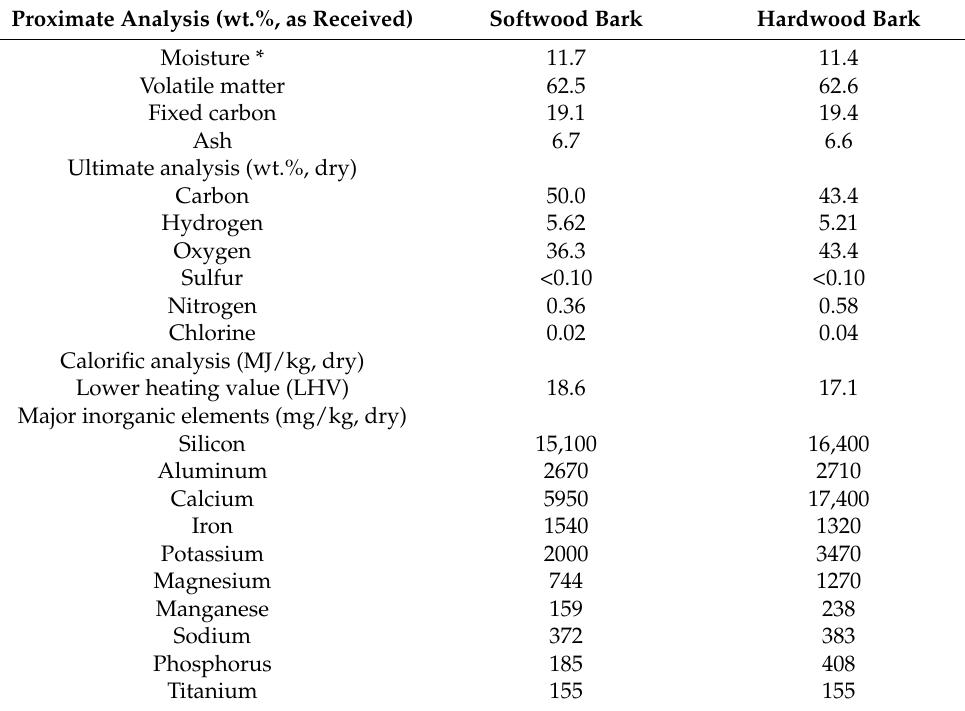
Table 1. Fuel composition of softwood bark and hardwood bark pellets as delivered. Proximate Analysis (wt.%, as